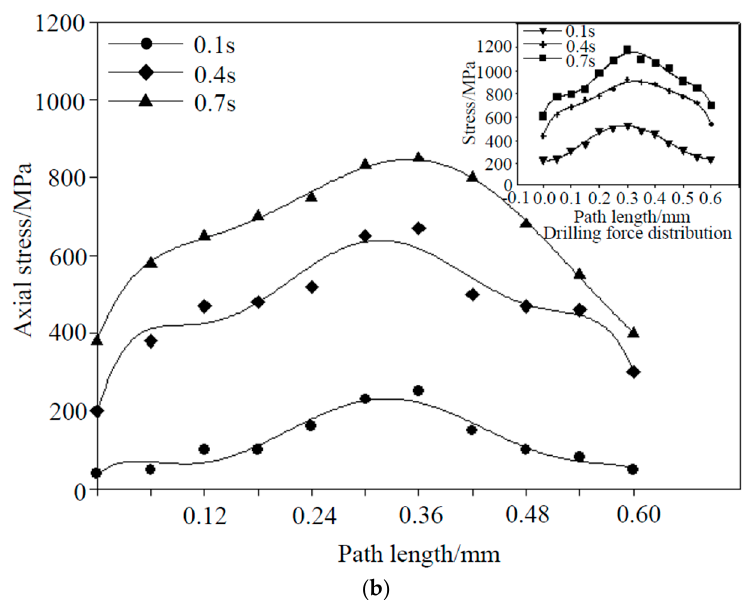
Figure 8. Stress distribution at the junction between whiskers and matrix. ( a ) Shear stress distribution; ( b ) axial stress distribution.